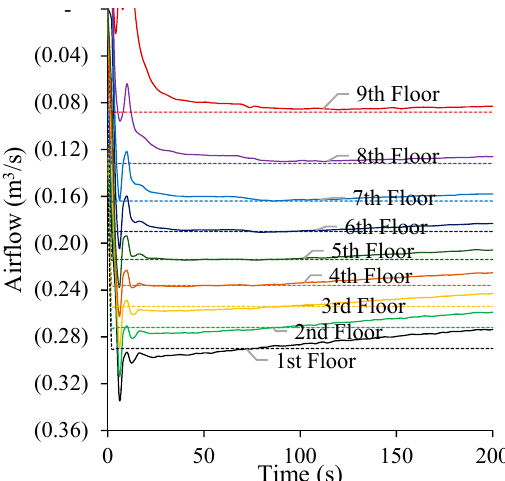
Figure 18. Airflow through stairwell doors for 10 th floor openings in FDS and CONTAM.